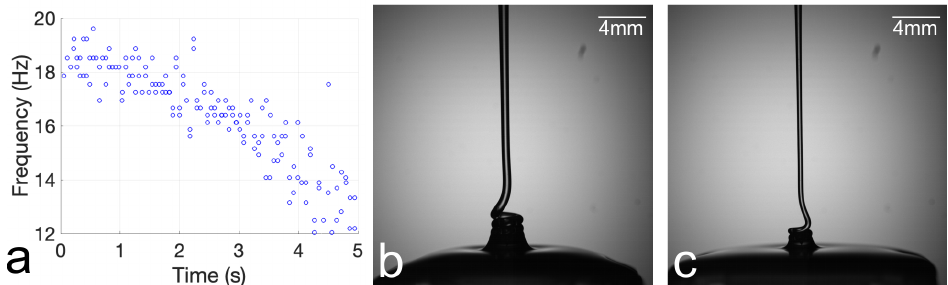
Figure 8. Coiling frequency as a result of transient flow rate using honey. The flow rate was decelerated from an initial, steady flow rate of 0.7 mL · s − 1 to 0.15 mL · s − 1 over 3 s at a fall height of 6 cm. ( a ) The coiling frequency dropped continuously with decreasing flow rate. Images of the coil ( b ) before and ( c ) after deceleration show the changes in the coil.